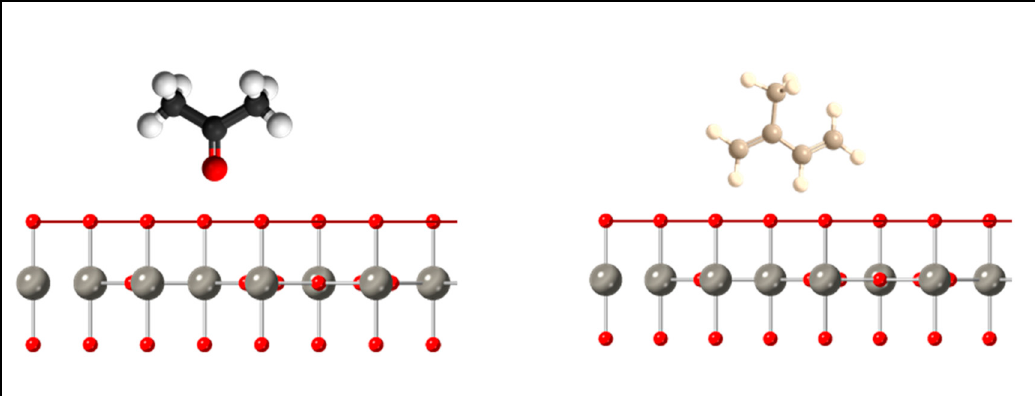
Figure 7. Potential molecule interaction orientation with the (001) facet of the h - WO 3 structure. Red horizonal line indicates the (001) plane. Red and grey spheres represent oxygen and tungsten atoms, respectively.